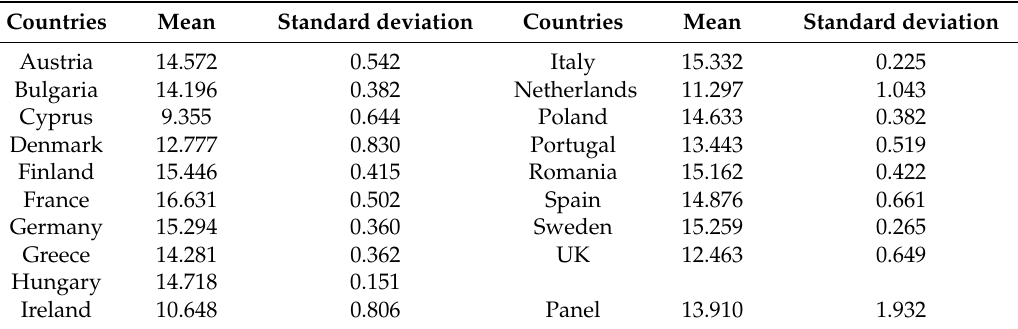
Table 1. Mean and standard deviation of wood fuel